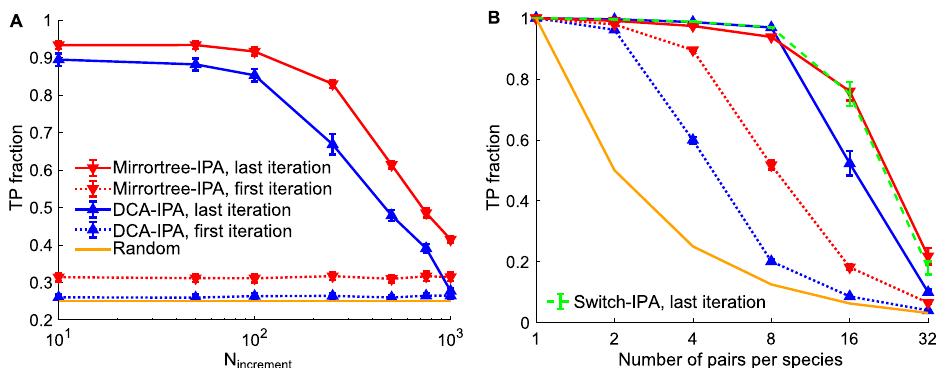
Fig 5. Pairing prediction without any training set. A : The fraction of pairs AB correctly predicted (TP fraction) is shown versus the increment step N increment of the iterative process, for the DCA-IPA and the Mirrortree-IPA, at the first and last iterations. Data was generated using a tree of 10 generations, with 20 mutations per branch on average, out of 200 bits in each chain AB, thus yielding 1024 chains AB, and random species with 4 pairs AB each were constructed. B : TP fraction versus number of pairs per species, for the DCA-IPA and the Mirrortree-IPA, at the first and last iterations, as well as for the Switch-IPA, which uses the Mirrortree pairing score for the first half of iterations and then switches to the DCA pairing score (the first iteration is thus the same for the Switch-IPA as for the Mirrortree-IPA). An increment step N increment = 100 was used. Data was generated using a tree of 10 generations, with 5 mutations per branch on average, out of 200 bits in each chain AB, thus yielding 1024 chains AB, and random species with the same number of chains AB each were constructed. Colors are the same as in panel A, with the addition of the Switch-IPA. In both panels, predictions were made without any training set, and the first iteration employed random within-species pairings to compute the initial pairing scores. The Hungarian algorithm was employed to predict pairings. Results are averaged over 20 replicates in panel A and 100 in panel B, each corresponding to a different realization of the branching process used for data generation. Error bars represent 95% confidence intervals (in many cases, markers are larger than error